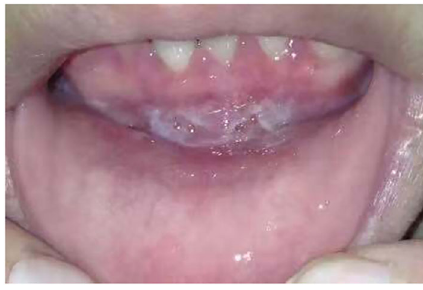
Figure 2. Ulceration of the oral